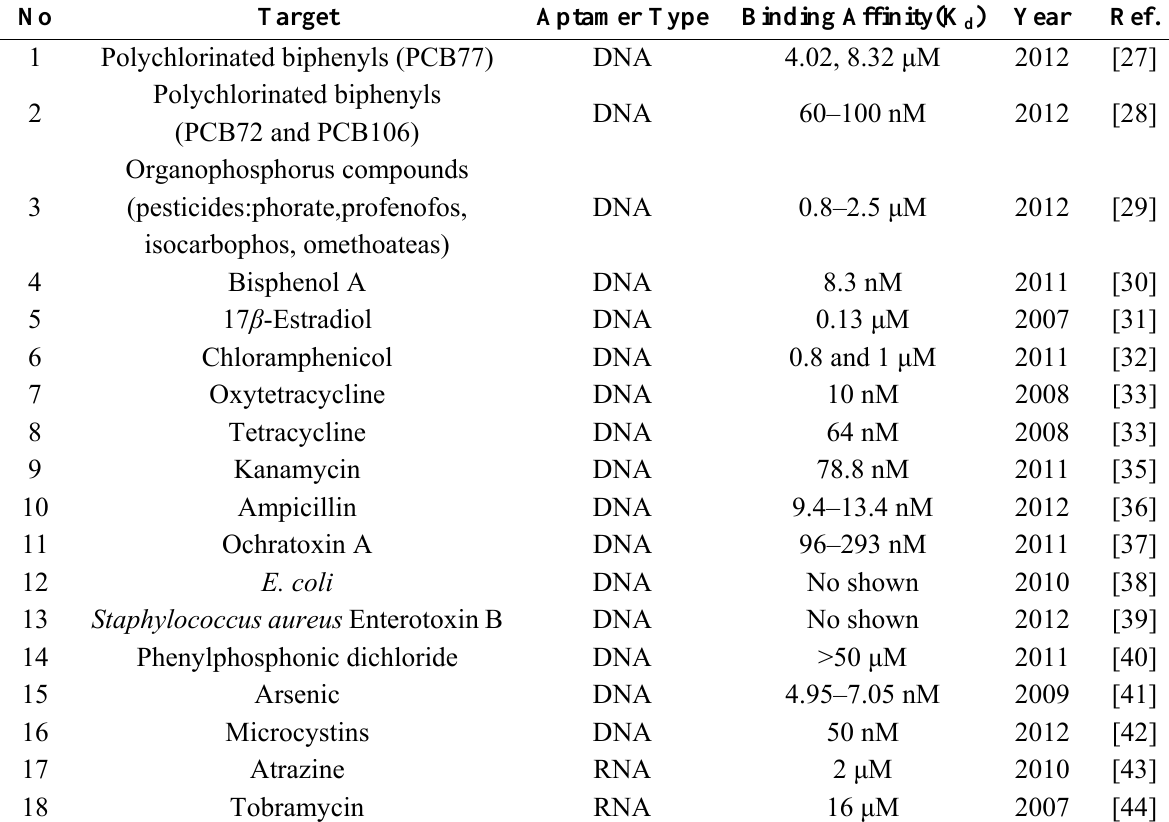
Table 1. A listing of DNA/RNA aptamers recently reported in the open literature that have been confirmed to bind to environmental pollutants. The dissociation constant (K measurement of binding affinity, is included, as well as the year of aptamer